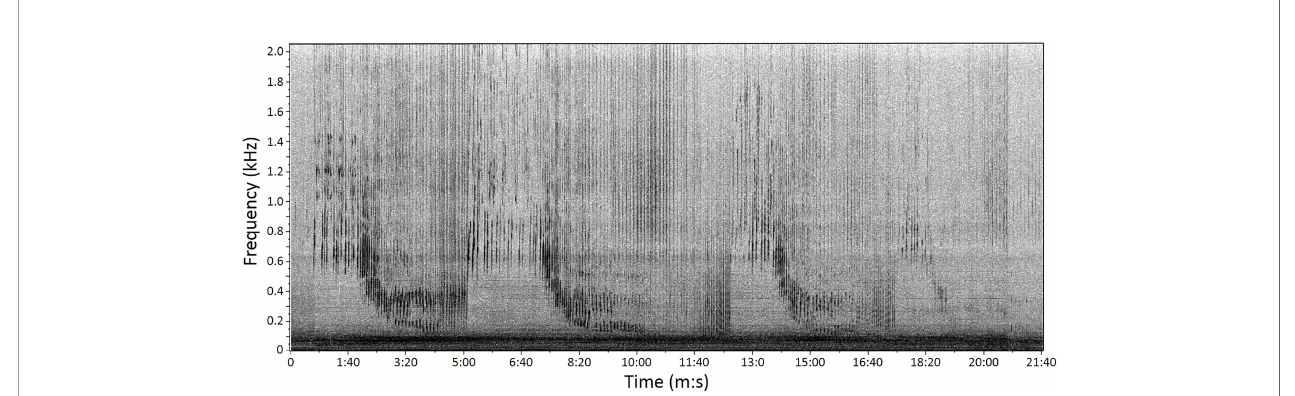
FIGURE 2 | Example of humpback whale song recorded off the west coast of South Africa from AAR2 on 7 July 2015. Spectrogram parameters: frame size 2.32 s, 90% overlap, discrete Fourier transform size 16,384